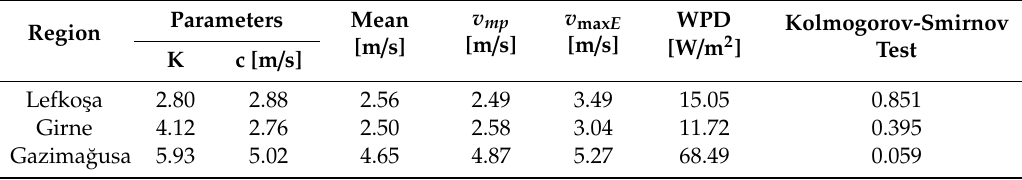
Table 4. Weibull parameters for each region (2010–2016) at a height of 10 m.